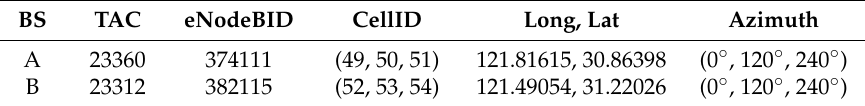
Table 2. Fundamental Information of BS A and B in